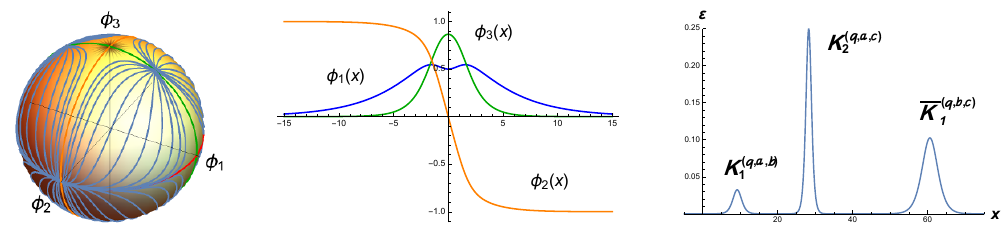
((cid:22) x; (cid:13) ) (left), (cid:12)eld components (middle) 4